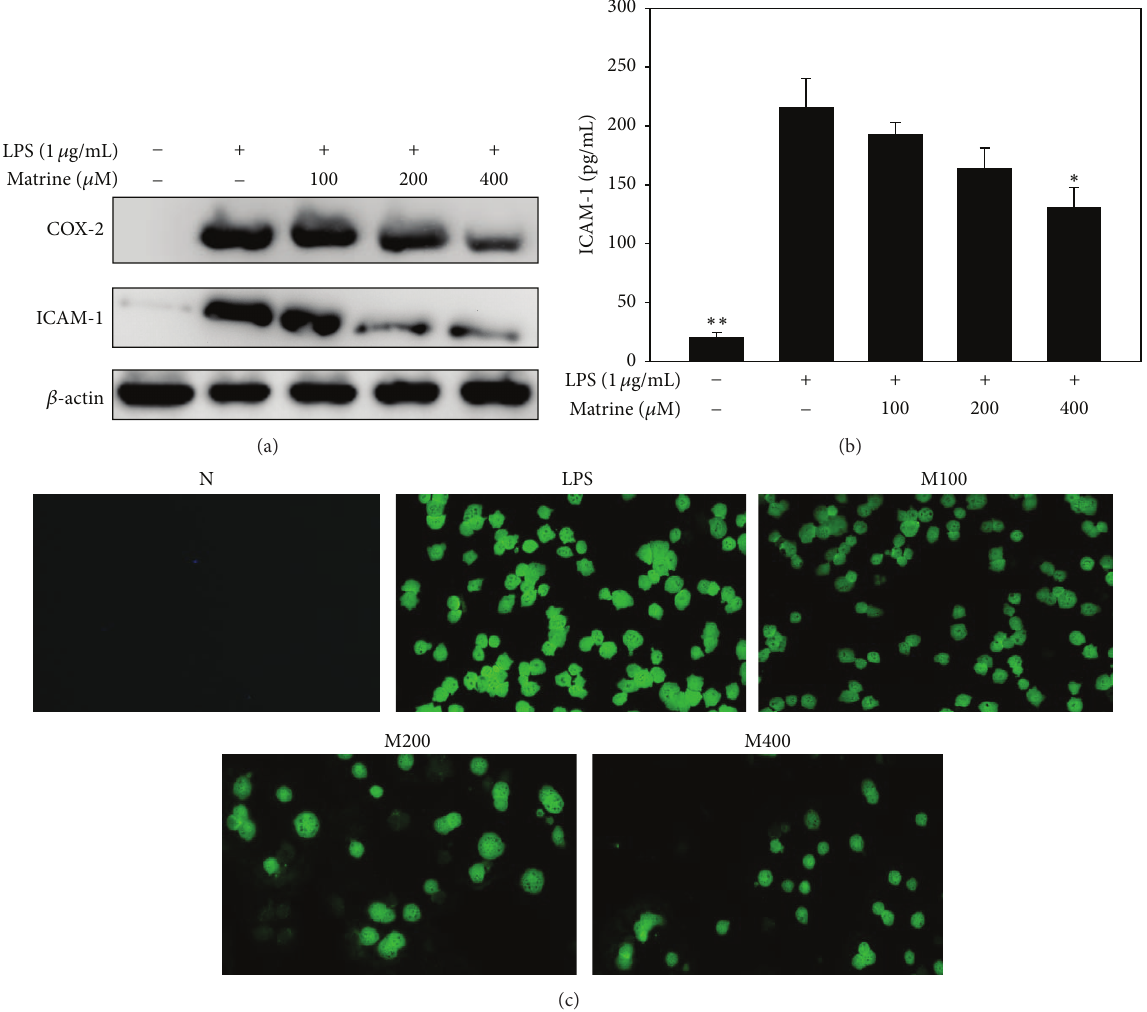
Figure 2: Matrine affects the LPS-induced productions of COX and ICAM-1 in A549 cells. COX-2 and ICAM-1 protein levels were detected using Western blots with 𝛽 -actin expression as an internal control (a), and ICAM-1 levels were measured by ELISA (b). (c) Treatment with 100–400 𝜇 M matrine (M) inhibited the adherence of neutrophil-like HL-60 cells to active A549 cells. Data are presented as the mean ± SEM. ∗ 𝑃 < 0.05 compared to LPS